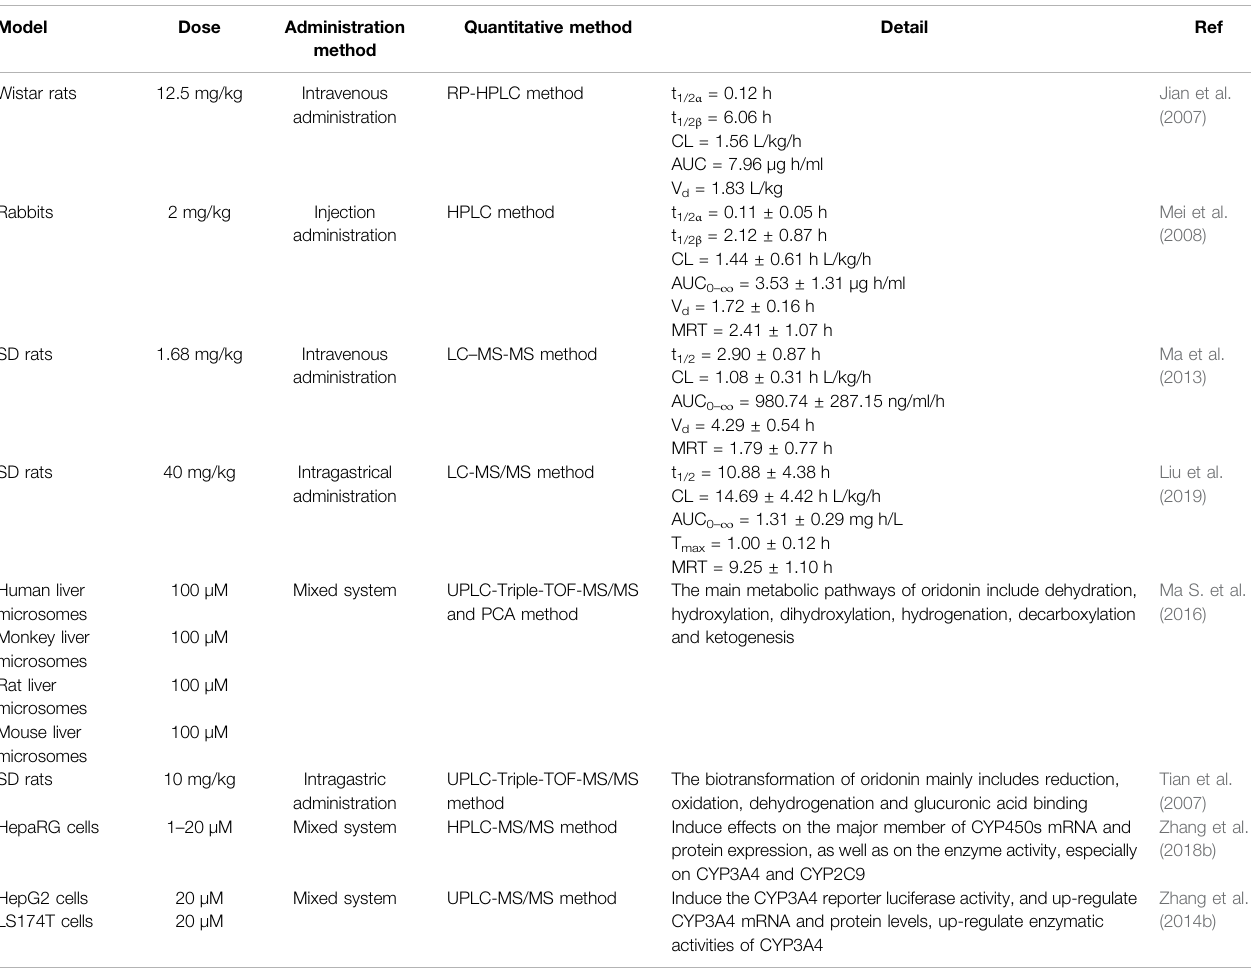
TABLE 2 | Pharmacokinetic information of